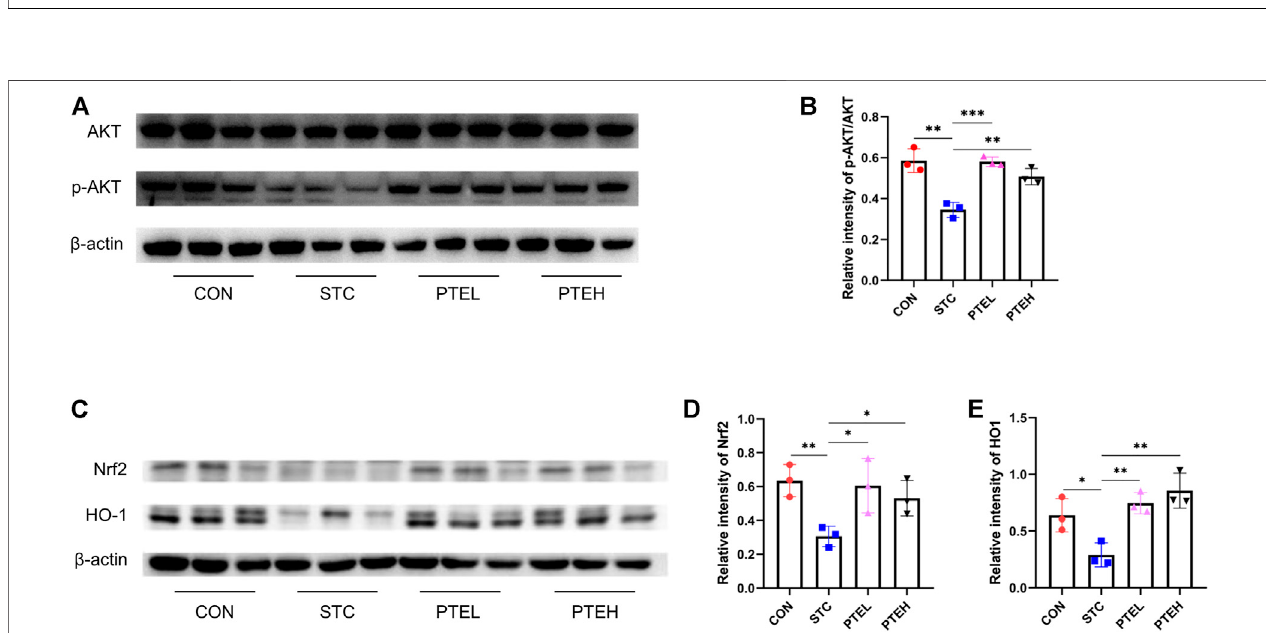
FIGURE 8 | Protein expressions of Nrf2, HO-1, p-AKT, and AKT in the colon. (A,C) Expression levels of p-AKT, AKT, and Nrf2/HO-1 protein in the colon and the quanti fi cation analysis was calculated in (B,D – E) . n = 3. * p < 0.05, ** p < 0.01, *** p < 0.001.